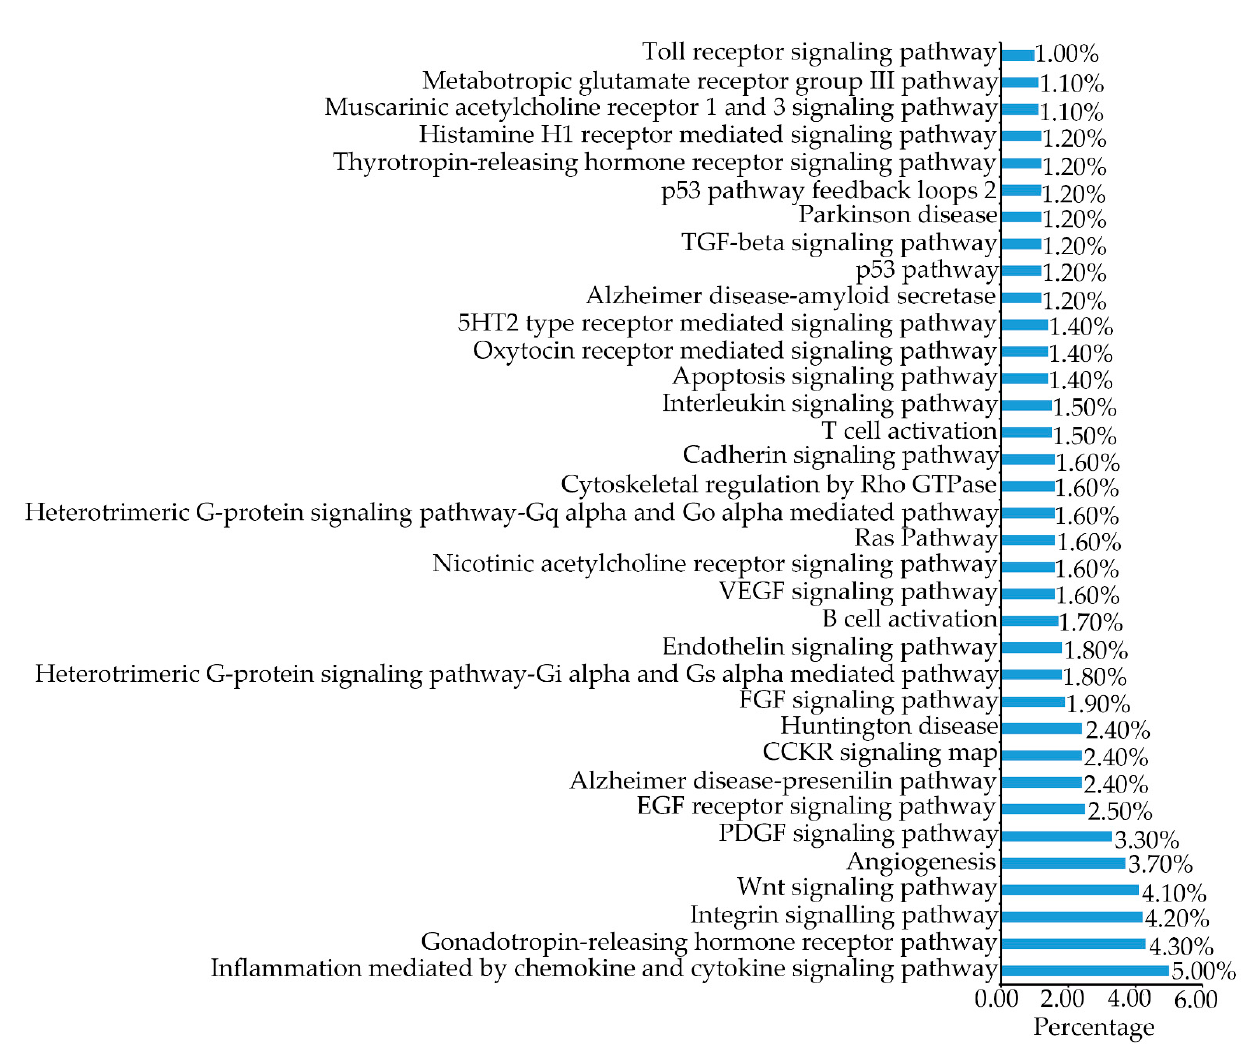
Figure 8. Gene-ontology (GO) functional annotation for cell signaling pathways. The gene-ontology (GO) functional annotation of 3485 expressed proteins in TILI-2 untreated and treated cells were classified using the PANTHER classification system according to the cell signaling pathway. Table 4. The relative quantitation ratios (log2) of proteins in the TGF beta signaling pathway and proteins involved in melanogenesis upon treatment with TILI-2 from proteomics data.